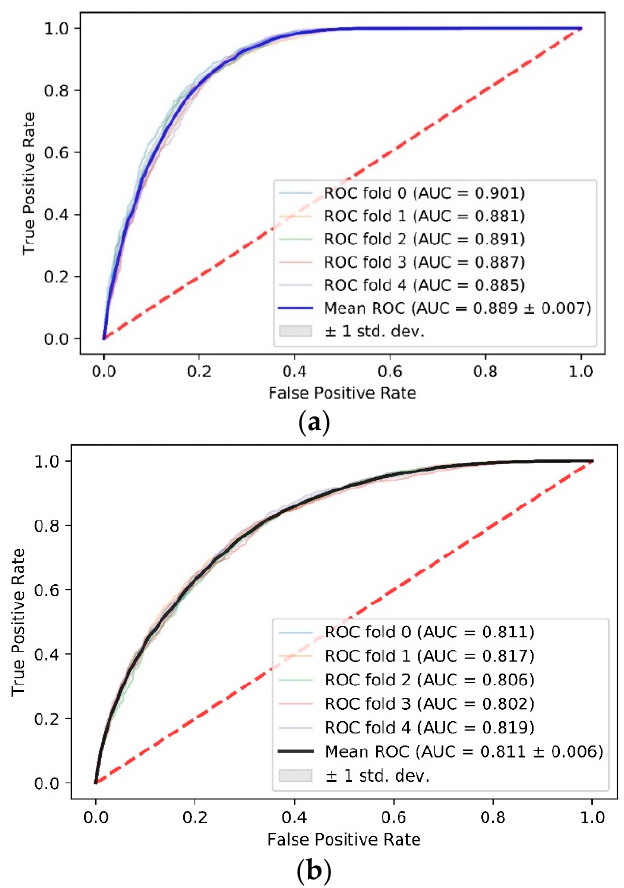
Figure 2. Comparison of AUC scores between data sets with high binding propensity and data sets randomly sampled. ( a ) ROC curve and AUC score of the high propensity data set using five-fold cross-validation; ( b ) ROC curve and AUC score of the random sampling data set using five-fold cross-validation. The red dotted line is a control line on which AUC = 0.5.